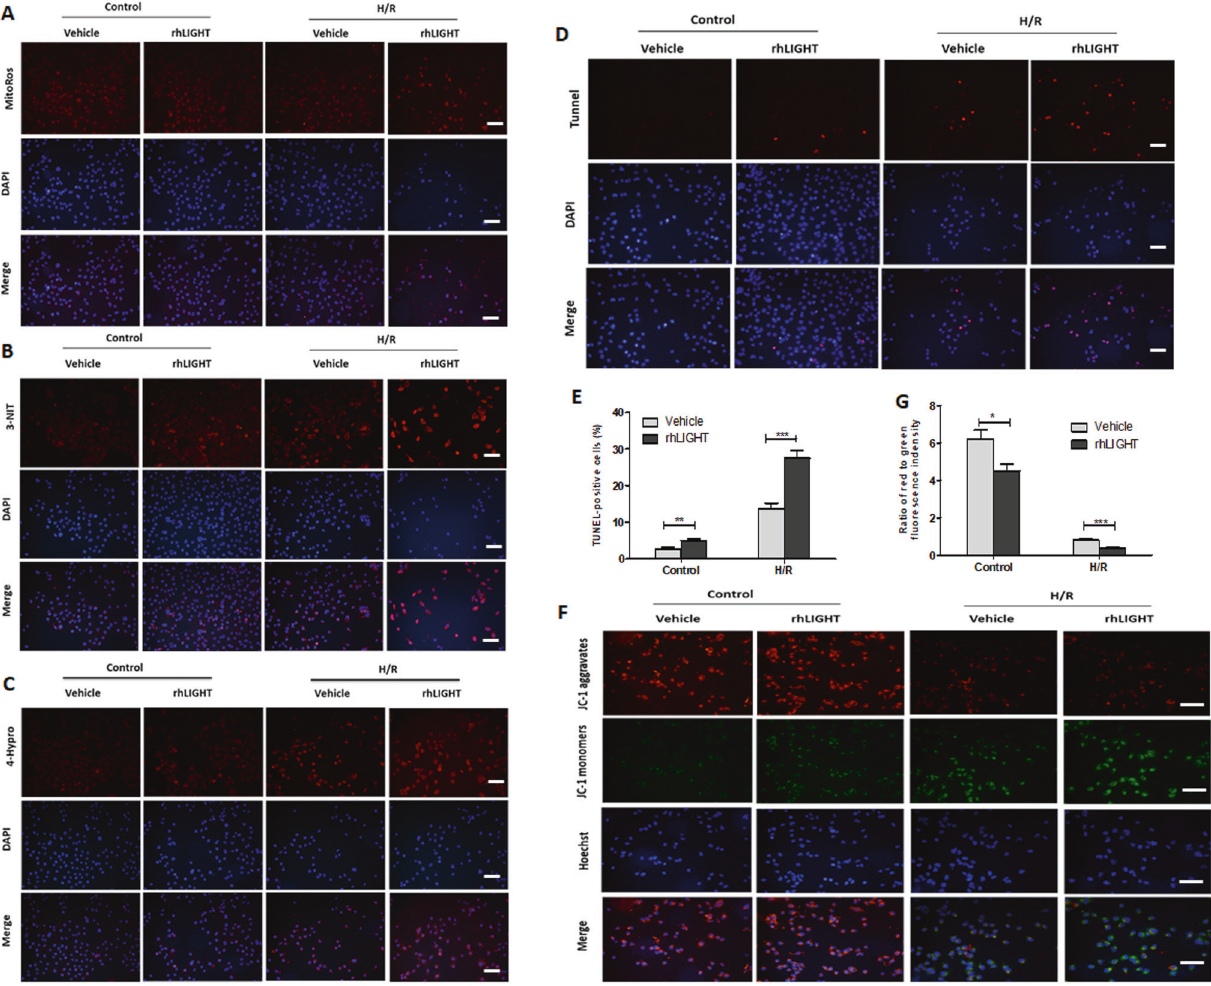
Fig. 6 Exogenous LIGHT stimulation promotes oxidative stress and injury in vitro. HK2 cells were treated with a normal culture medium or recombinant human LIGHT and exposed to H/R conditions. For H/R condition, cells were subjected to 2 h OGR followed by 24 h reperfusion under normal oxygen conditions. Representative images of IF staining for mitochondria ROS (mtROS; A ), 3-NIT ( B ), and 4-Hydro ( C ). Right panel: relative immuno fl uorescence density of mtROS, 3-NIT, and 4-Hydro. D Representative micrographs of TUNEL-positive apoptosis cells. E Quanti fi cation of TUNEL-positive cells is shown. F Membrane potential tested by JC-1 staining. Representative images of IF staining for mitochondria JC-1 aggravates (red) and monomers (green). G Ratio of red to green immuno fl uorescence density is shown. The nucleus was co-stained with DAPI (blue). Values are presented as mean ± SEM. Scale bar, 50 μ m. Differences between the two groups were assessed with Student ’ s t test. * p < 0.05; ** p < 0.01, *** p <